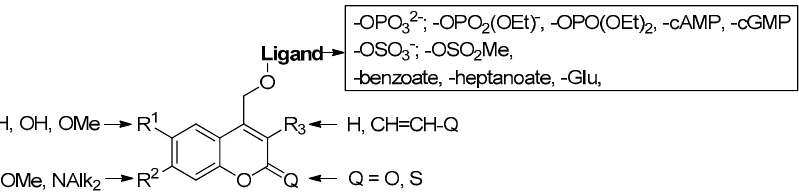
Figure 26. Some examples of cage compounds based on various coumarin scaffolds.